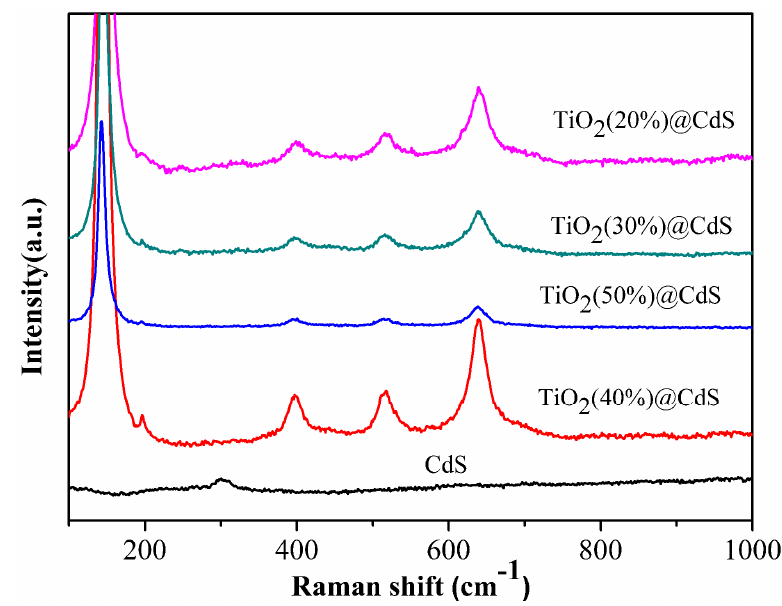
Figure 4. Raman pattern of TiO 2 nanorod–CdS nanoparticle composites.